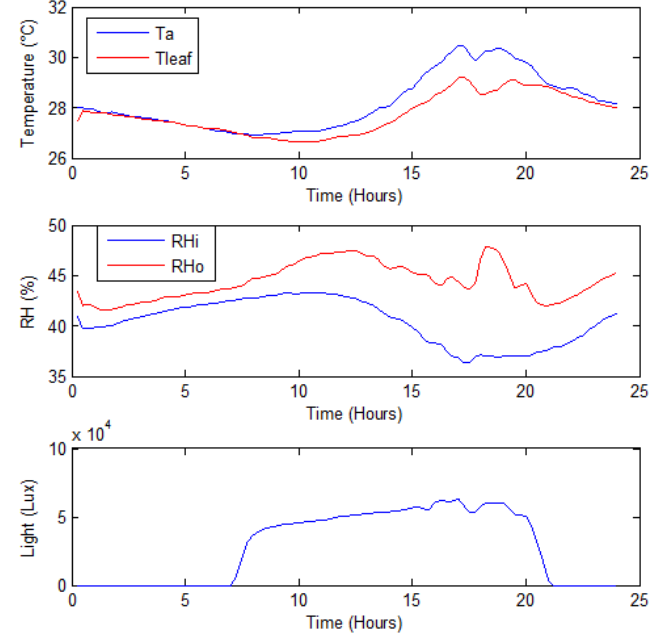
Figure 10. Primary sensor readings of the proposed smart sensor.